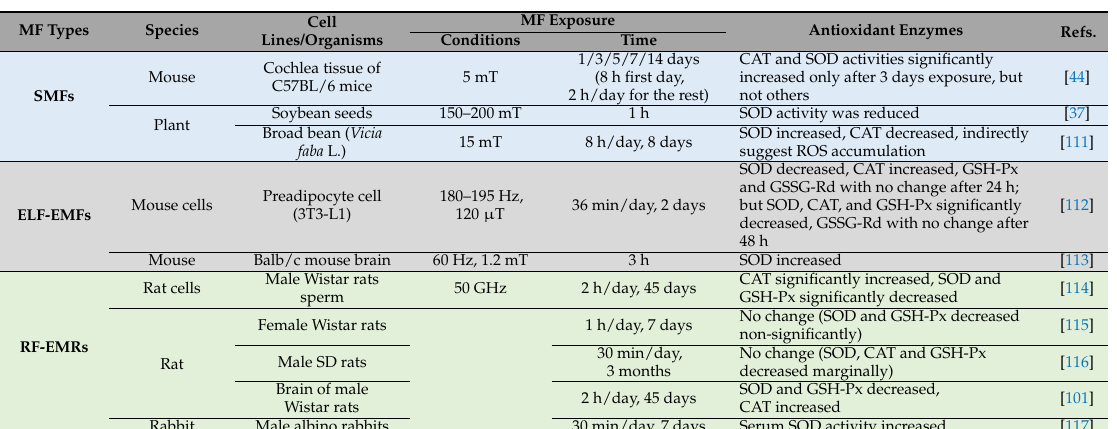
Table 6. The magnetic field (MF)-induced activities changes of antioxidant